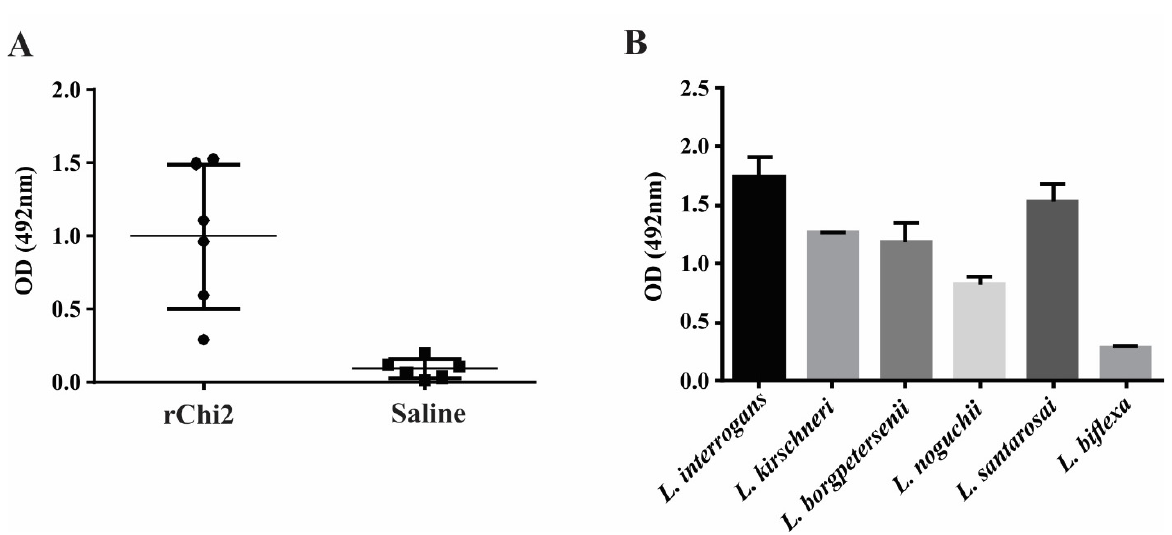
Figure 4. Immune response elicited via rChi2 immunization and Leptospira spp. cross-reaction. Hamsters (n = 6) were immunized subcutaneously with 50 μ g recombinant protein mixed with 12.5% Alhydrogel on day 0 and boosted after 2 weeks. Blood was collected 2 weeks after the last immunization and sera at 1:800 dilution were utilized for the determination of antibody titers regarding total IgG via ELISA ( A ). The hamsters in the negative control group (saline) were injected with Tris-NaCl buffer in 12.5% Alhydrogel. Pooled hyperimmune antiserum was used for antigen detection on the surface of intact immobilized Leptospira spp. via ELISA ( B ). Saprophyte L. biflexa was used as a control.